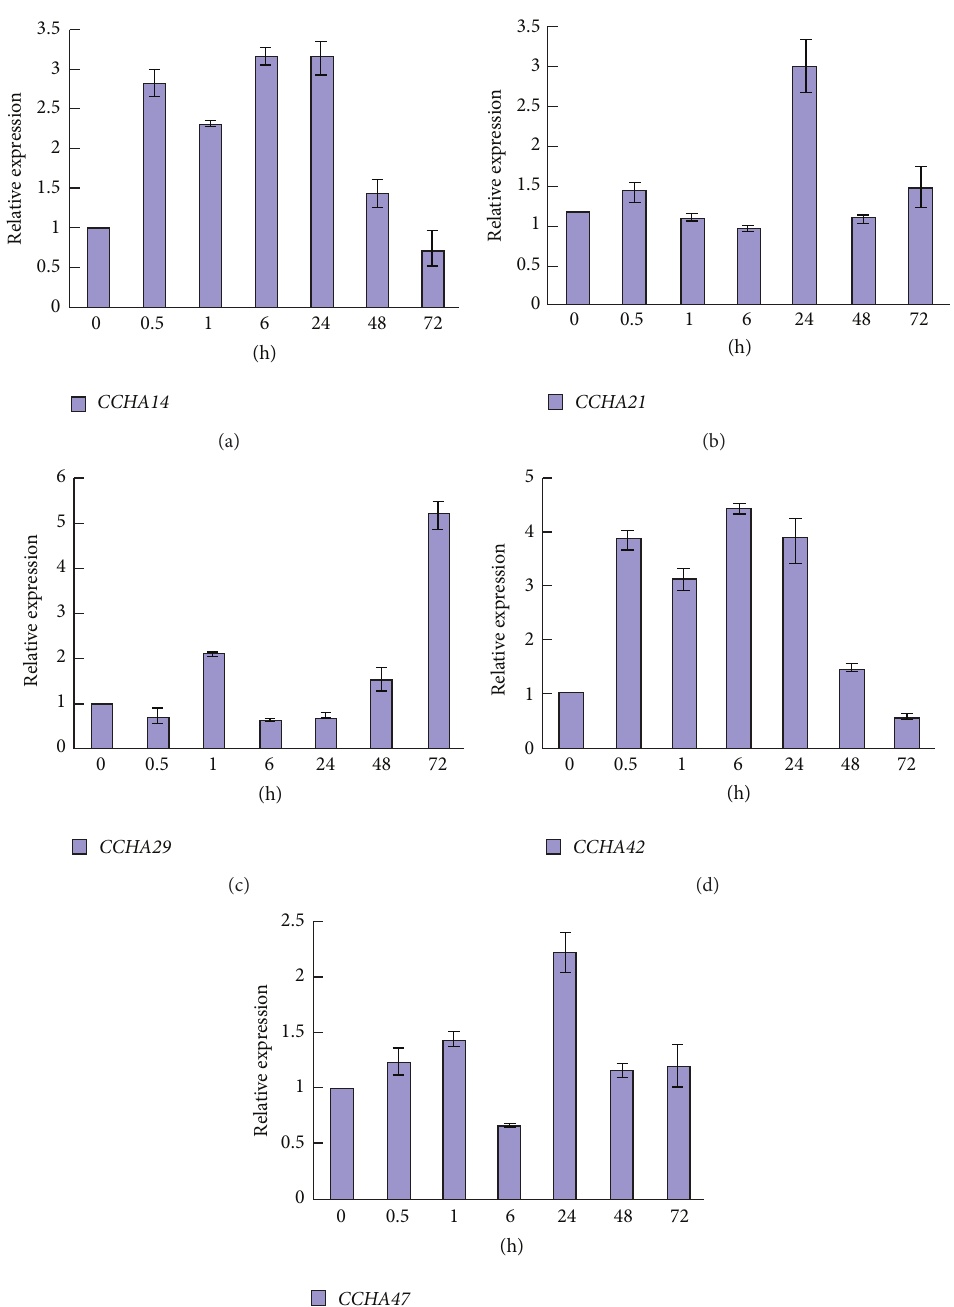
Figure 2: Expression patterns of candidate A. glaucus salt-tolerance genes. Real-time PCR analysis of CCHA-2114 (a), CCHA-2221 (b), CCHA- 2229 (c), CCHA-2142 (d), and CCHA-2247 (e) in A. glaucus CCHA under 3 M NaCl stress for 0, 0.5, 1, 6, 24, 48, and 72